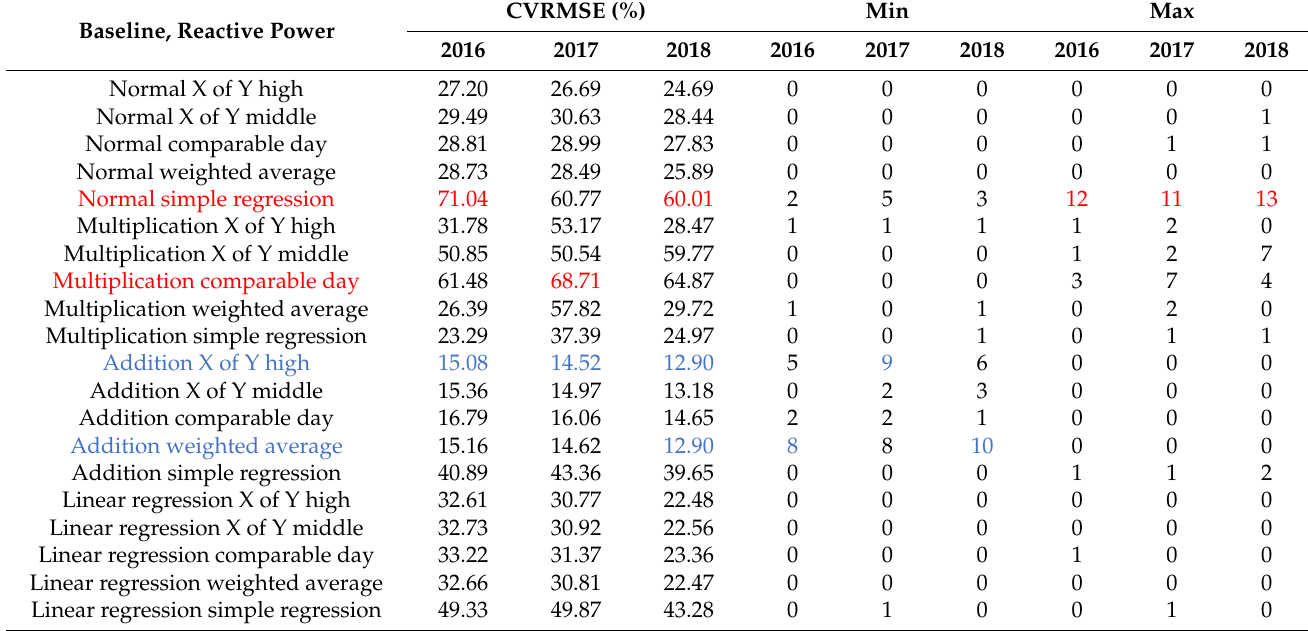
Linear regression weighted average